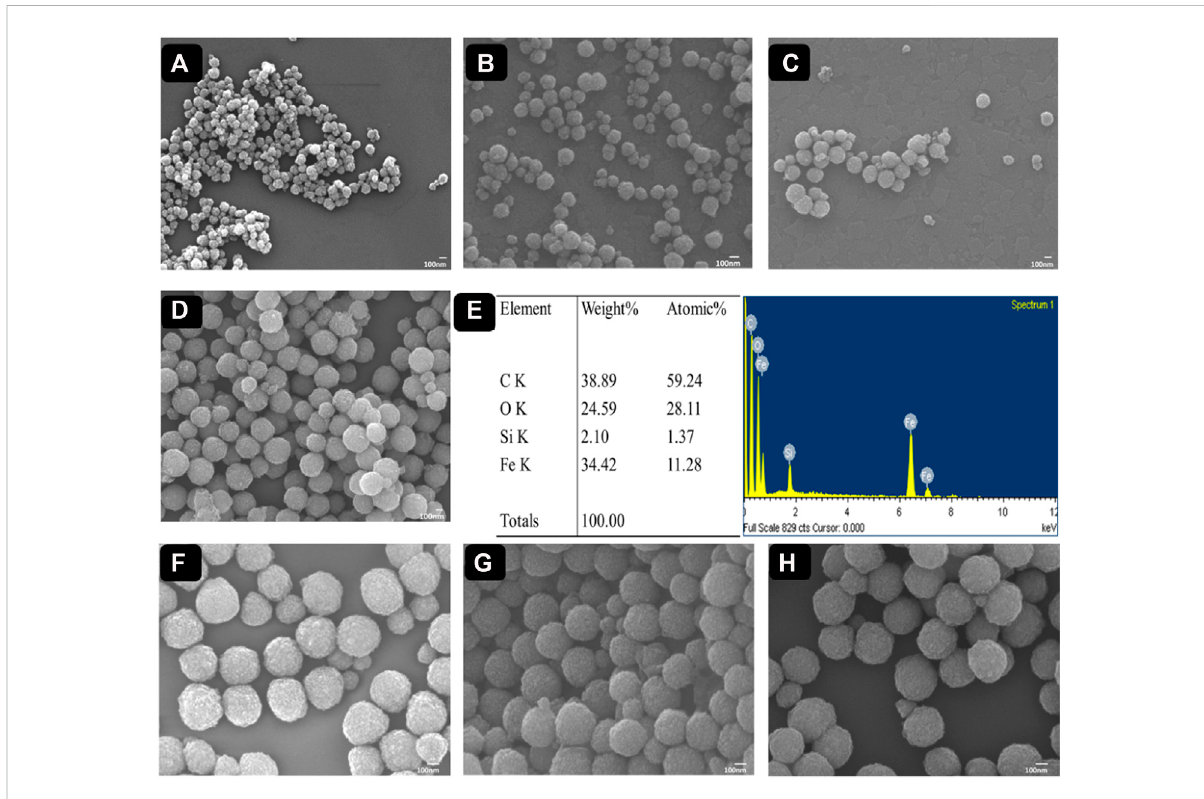
FIGURE 5 FE-SEM images of (A) Fe 3 O 4 , (B) Fe 3 O 4 @APTMS, (C) Fe 3 O 4 @APTMS-GA, and (D) Fe 3 O 4 @APTMS-GA-acrylate. The EDX spectrum image of (E) Fe